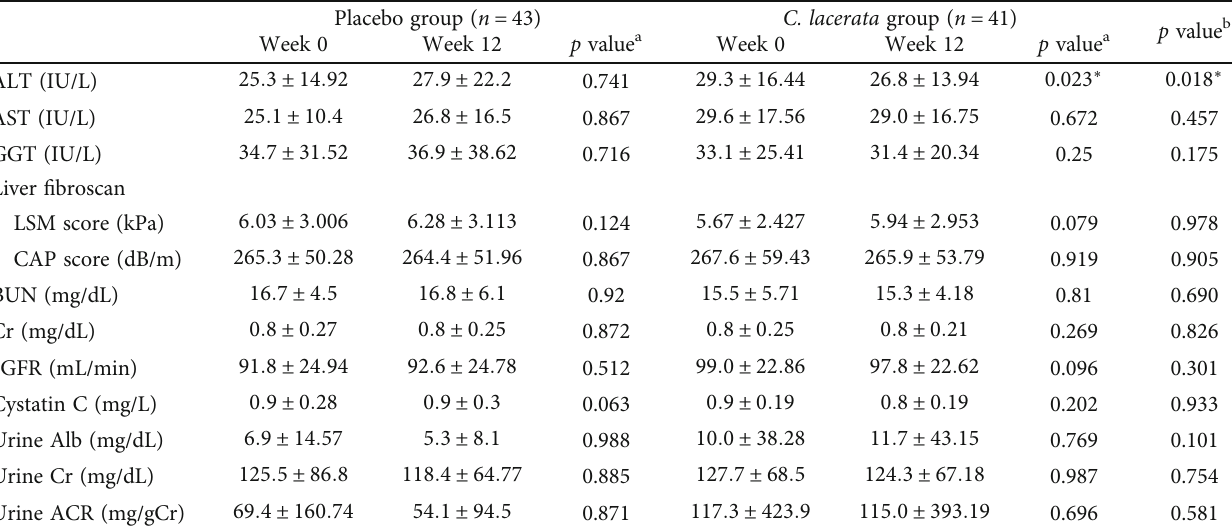
Table 3: Biochemical measurements of hepatic and renal function. Placebo group ( n = 43 ) C. lacerata group ( n = 41